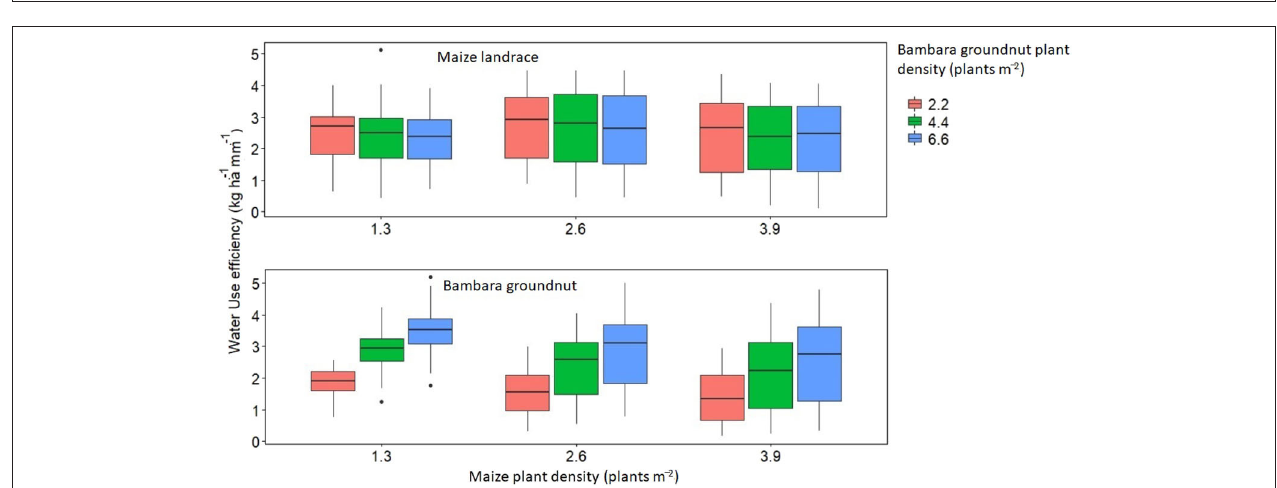
FIGURE 8 | Simulated yield response of maize landrace and bambara groundnut to plant population (plant m − 2 ) for climate scenarios obtained from six GCM (ACC, CSS, CNR, GFD, NOR, and MPI). Different colors of boxplots represent the bambara groundnut plant density (plant m − 2 ). The effect of the interaction between maize landrace plant density and bambara groundnut plant density on maize landrace grain yield - F -statistic: 62.47 on 8 and 891 DF, P = 0.000. The effect of the interaction between maize landrace plant density and bambara groundnut plant density on bambara groundnut grain yield - F -statistic: 38.93 on 24 and 875 DF, P = 0.000.